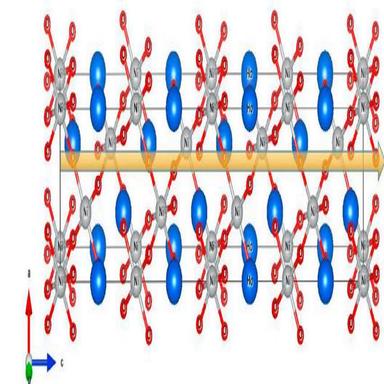
Total energies of the FM, NM, and AFM states of rhombohedral R3c-type HoNiO3 with a 1 � 1 � 2 superlattice.